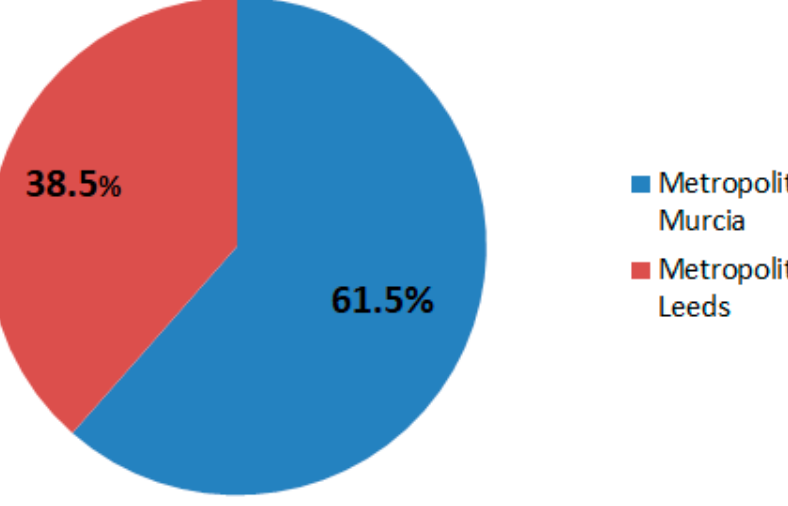
Figure 3. Religious connotations per metropolitan district (percentages).